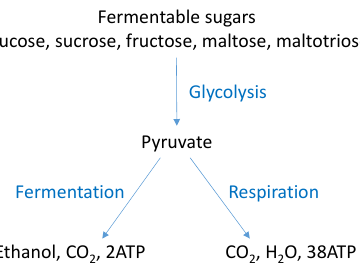
Figure 3. The fate of sugars during S. cerevisiae metabolism.